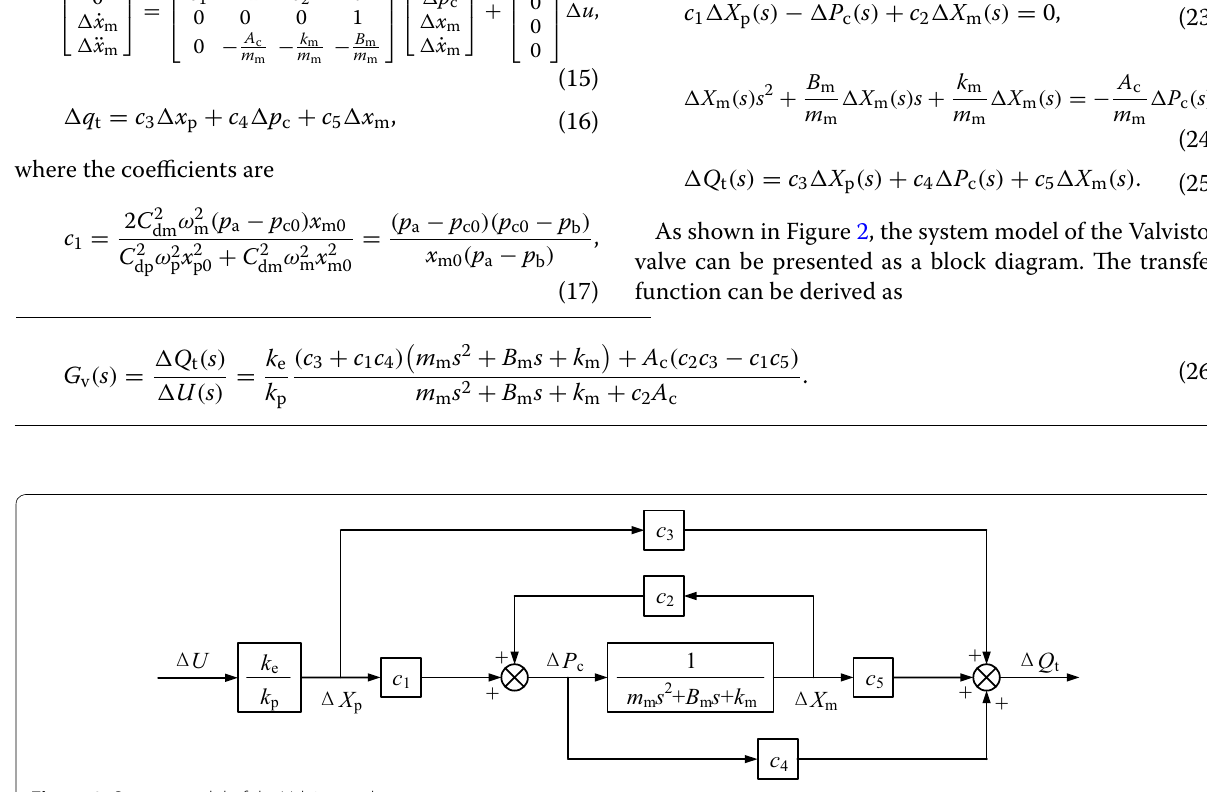
Figure 2 System model of the Valvistor